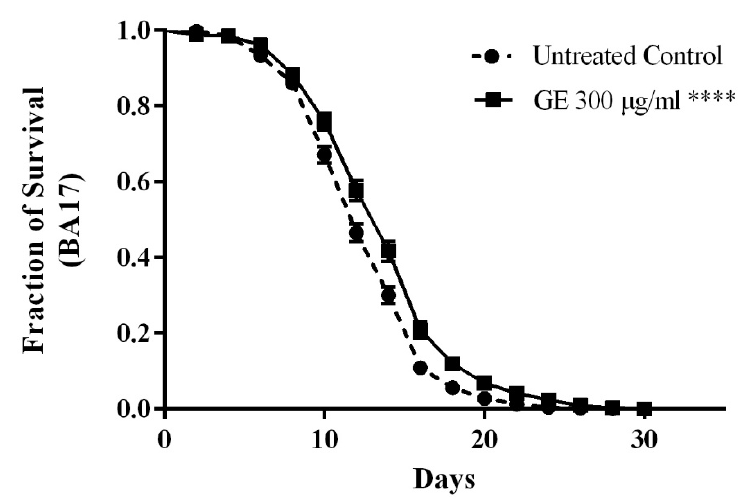
Figure 4. Influence of GE treatment on longevity of the mutant worms BA17. GE 300 µ g/mL increased the lifespan significantly as compared to the control group. The results are presented as percentage of survival and the statistical significance was determined by Log-rank (Mantel-Cox) tests followed by Gehan-Breslow-Wilcoxon Test. **** p < 0.0001. Caloric restriction (CR) is known as a potent lifespan enhancer [28]. In order to investigate whether worms treated with GE underwent caloric restriction during the course of the experiment, the pharyngeal pump rate was measured (which would decrease in case of CR). The pumping activity was scored in GE treated and untreated N2 (wt) worms at day 5, 8 and 10 of adulthood. The results obtained indicate a positive effect of GE throughout all periods of observation. The pumping activity of the GE treated group was 60% higher at day 10 compared to the untreated control group ( p ‐ value < p < 0.0001) (Figure 5).